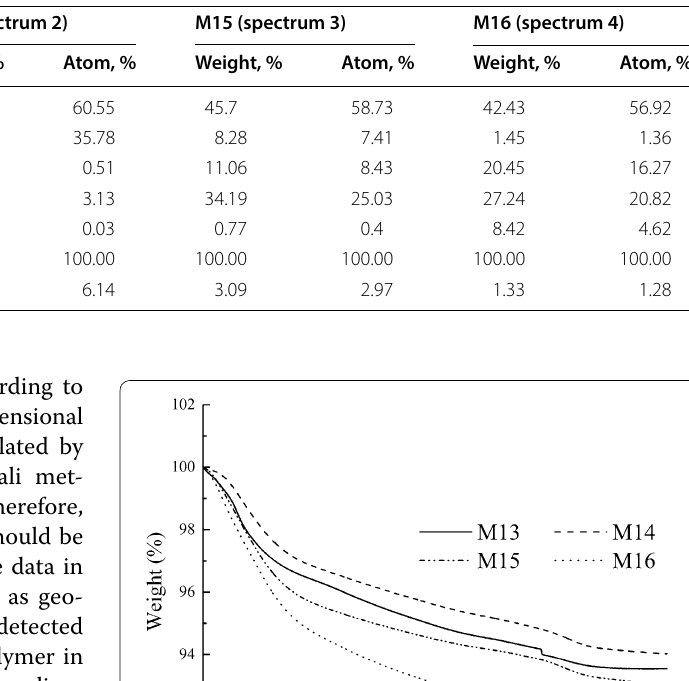
Table 7 Elements analysis of specimens in weight % and atom %.